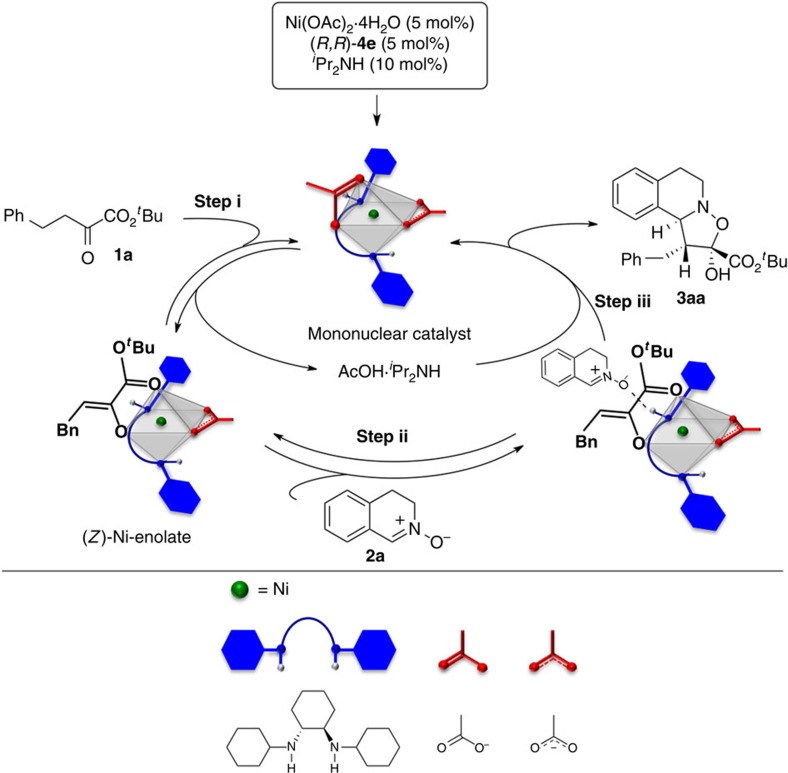
Proposed catalytic cycle.The formal [3+2] cycloaddition of 1a with 2a using the catalytic triad Ni(OAc)2, (R,R)-4e and iPrNH2.